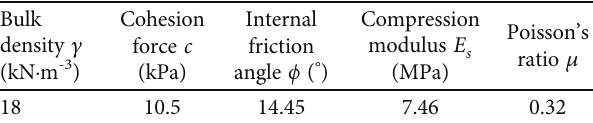
Table 2: Physical and mechanical parameters of stratum. Bulk density γ (kN · m -3